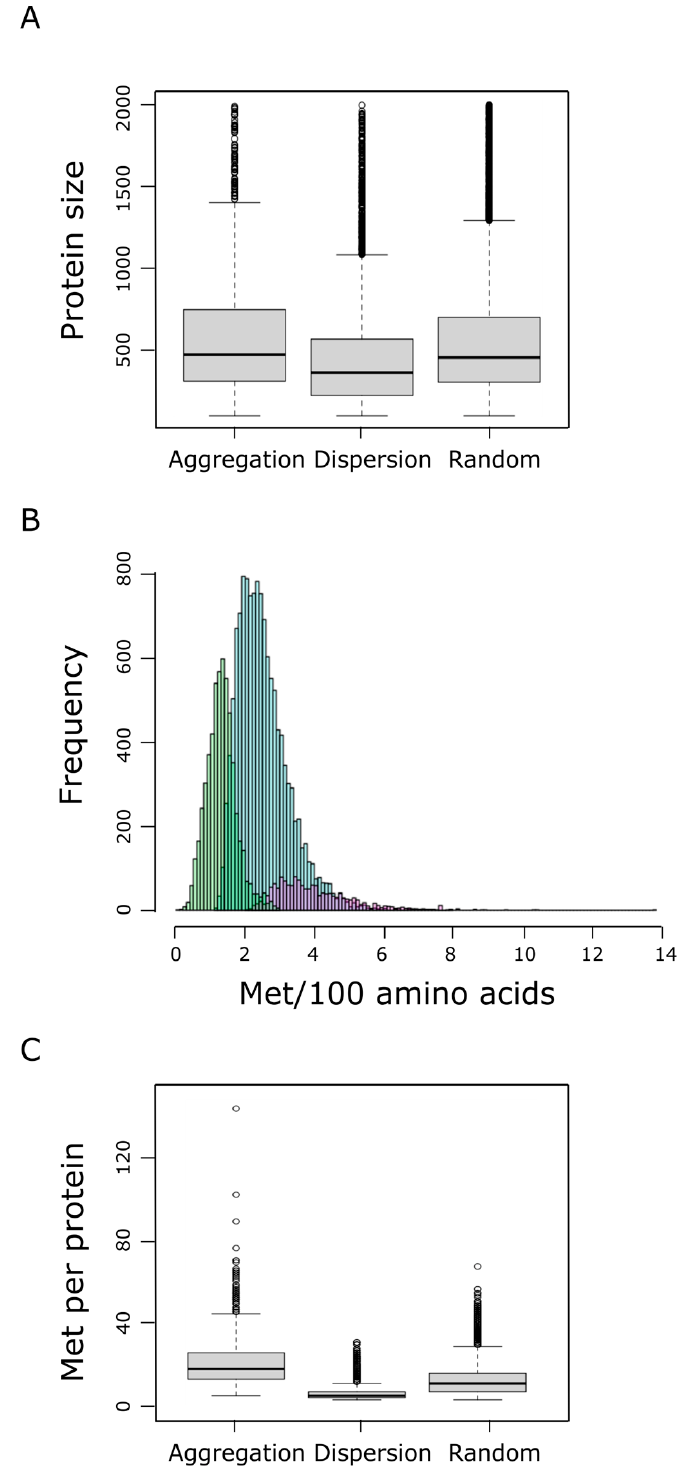
Figure 4. Protein size distributions within the aggregation, dispersion, and random groups are shown in ( A ). The percentage of methionine content in the human proteome, which ranges from 0 to near 14%, was assessed. The absolute frequency of the different methionine contents is shown in ( B ), where differential trends for the dispersion (green), random (blue), and aggregation (purple) groups can be distinguished. In ( C ) the distribution of the absolute methionine frequency for each of these three groups is shown.